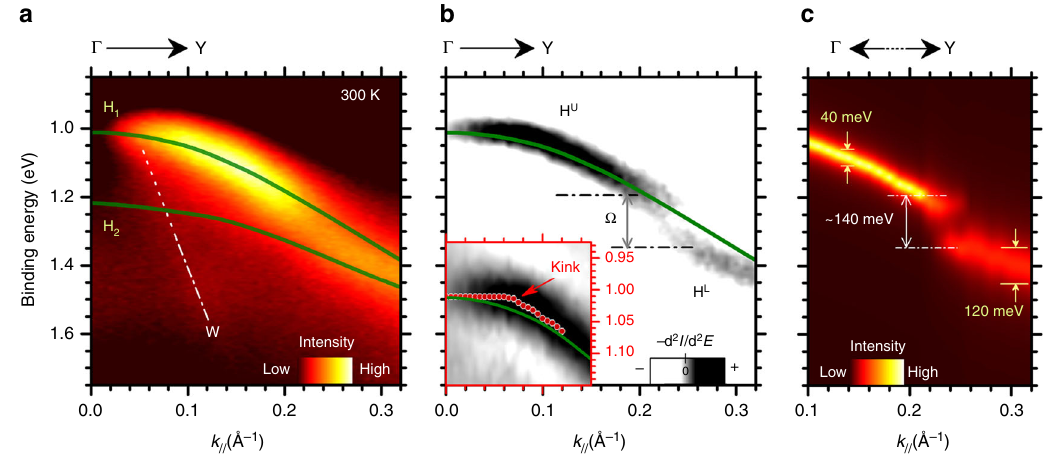
Fig. 2 Angle resolved band map at 300 K and theoretical calculations. a ARUPS intensities vs. k // along the Γ Y direction of rubrene single crystal at 300 K. Theoretical HOMO band dispersions are plotted as continuous green lines . b Second derivative ARUPS intensity map ( – d 2 I/d 2 E , where I is the ARPES intensity and E the binding energy) as obtained from data in a . The splitting of the HOMO band in two subband H U and H L is evidenced as separated by gap Ω . Inset: Magni fi cation of second derivative map close to Γ point. Experimental H peak positions are also indicated by red circles and compared with theoretical band dispersion (continuous green line ) to highlight the kink-like distortion. c Intensity map of H peak Lorentzian component along the Γ Y direction, as extracted from HOMO peak fi tting procedure. The intensities of Lorentzian components were normalized with respect to the peak